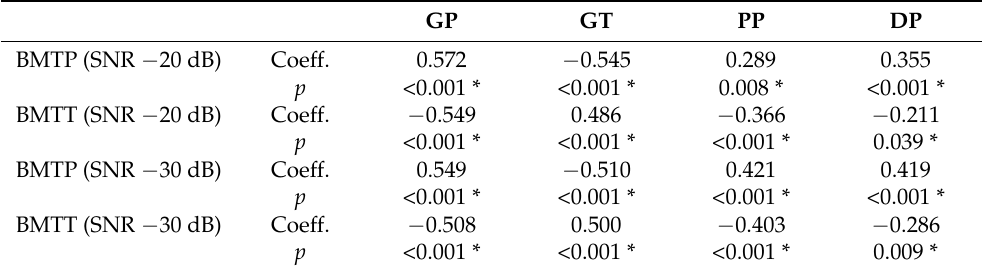
Table 4. Correlation coefficients between backward masking test (BMT) measures and performance in clinical auditory temporal processing tests for the total